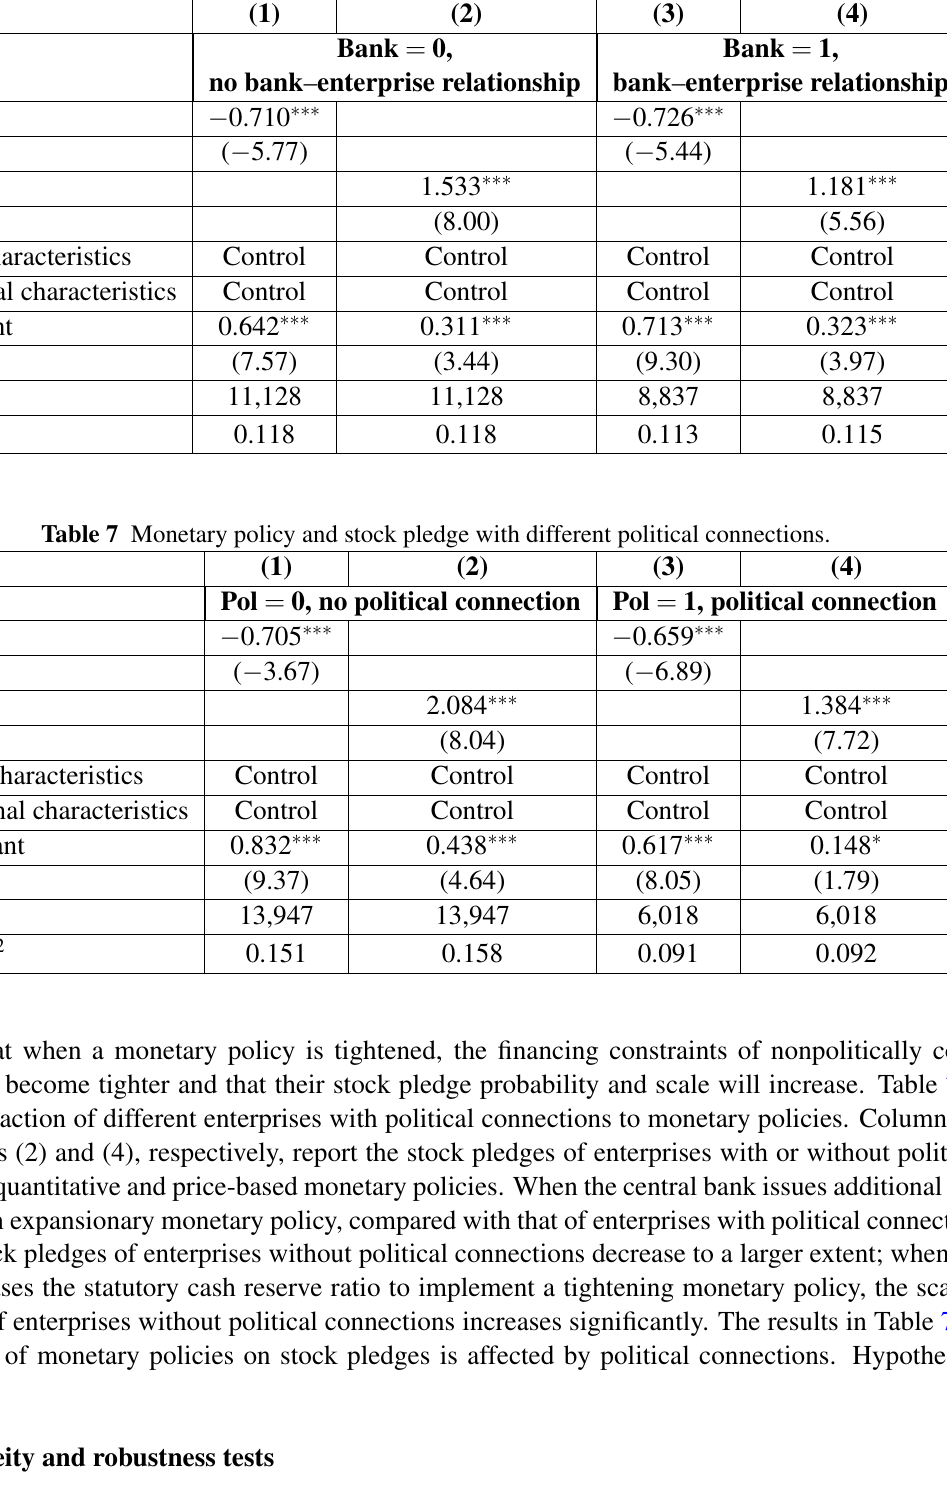
Table 6 Monetary policy and stock pledge with different bank–enterprise relationships.